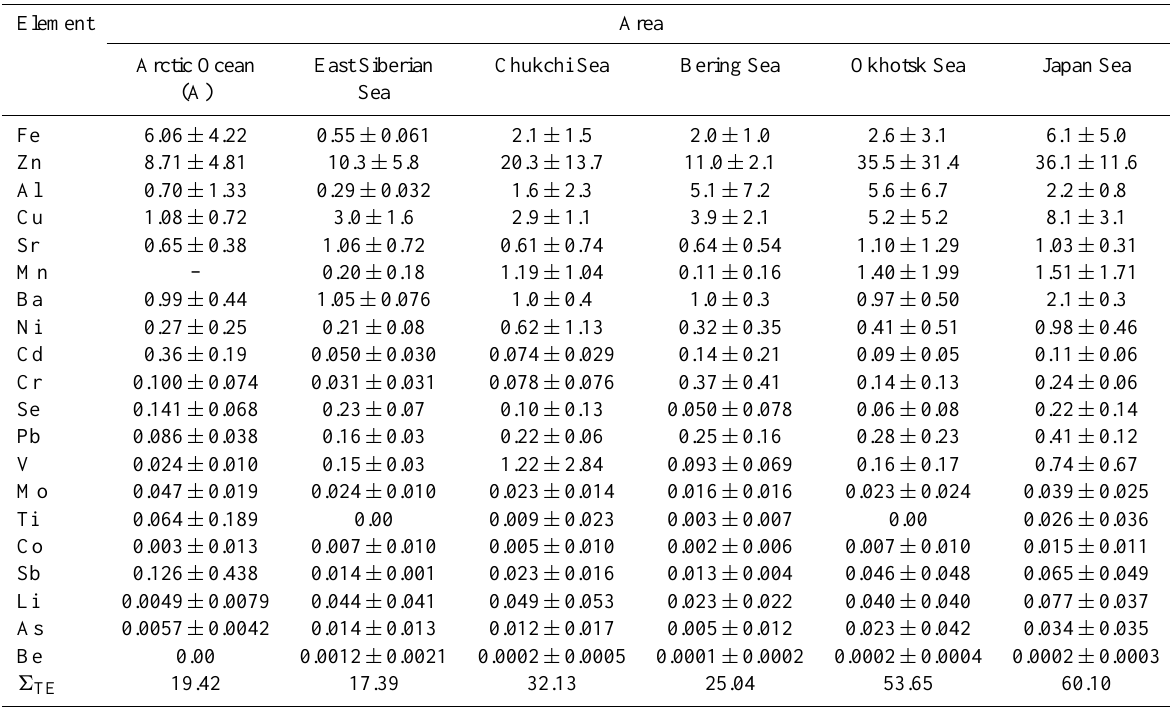
Table 7. Average values ( ± SD) of concentrations (ngm − 3 ) of water-soluble elements in aerosol along the route of RV Akademik Fedorov and Professor Khljustin (July–September